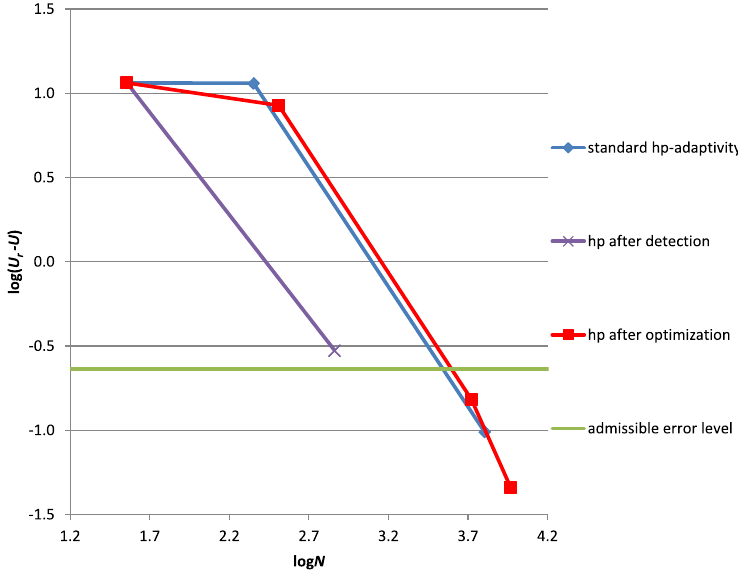
Figure 20. A bending-dominated plate—convergence for three adaptation